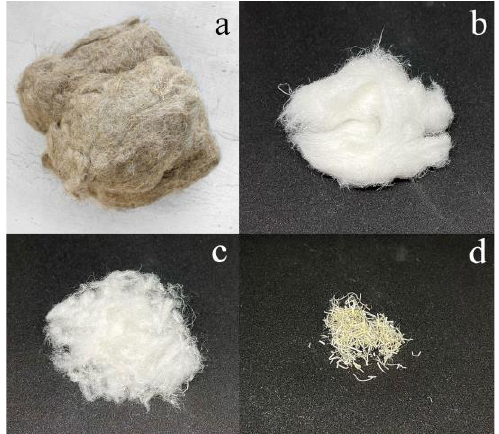
Figure 1. Photos of the original flax fibers ( a ), linen wadding ( b ), noils ( c ) and shives ( d ).